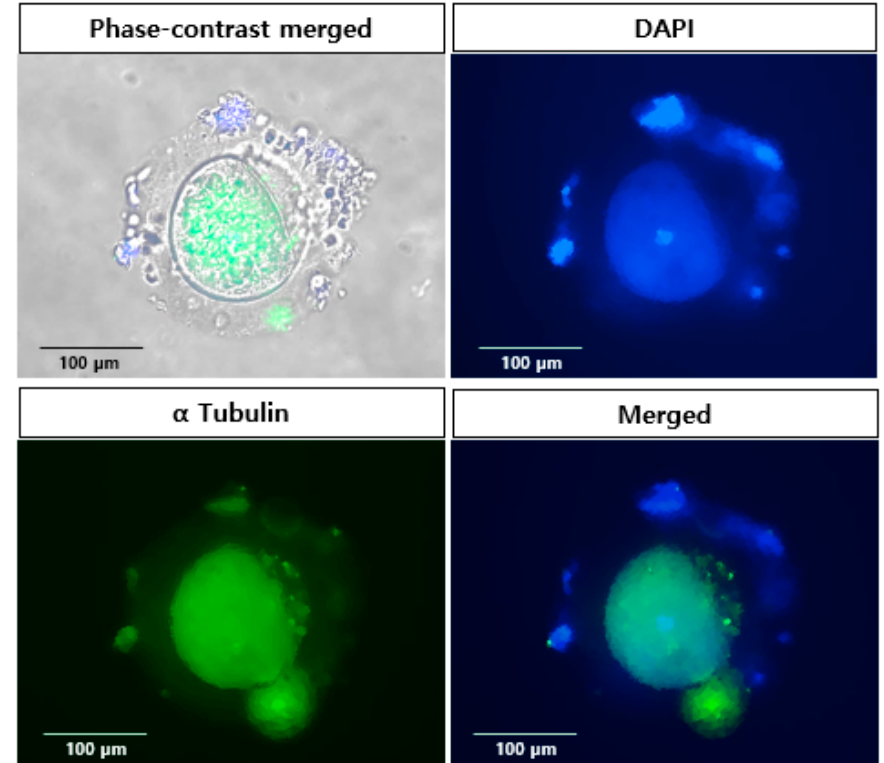
Figure 4. Localization of specific protein in in vitro matured marmoset oocytes. Immunofluorescence demonstrates the expression of alpha tubulin. The localization was confirmed using merged images of phase-contrast and fluorescence images. Magnification: ×